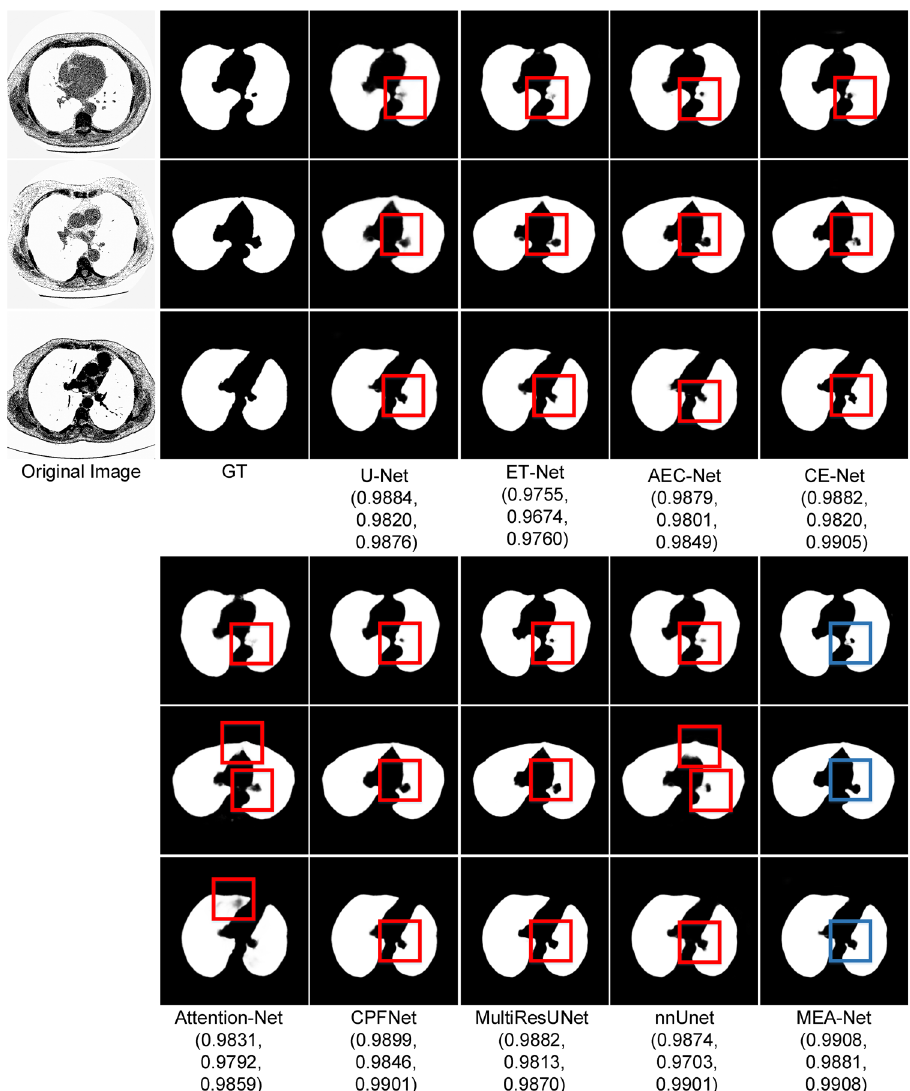
Figure 8. Sample results of LUNA segmentation. (The Dice values for each legend are in